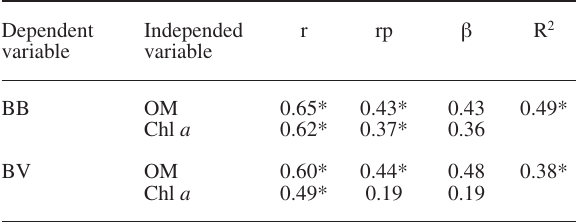
Table 3. – Multiple regression equations and statistics predicting sediment bacterial biomass (BB) and biovolume (Bv) (r, Pearson’s correlation coefficient; r , partial correlation coefficient; β , beta co- p efficient; r, coefficient of multiple regression; r 2 (%), coefficient of multiple determination; oM, organic matter; chl a , chlorophyll a